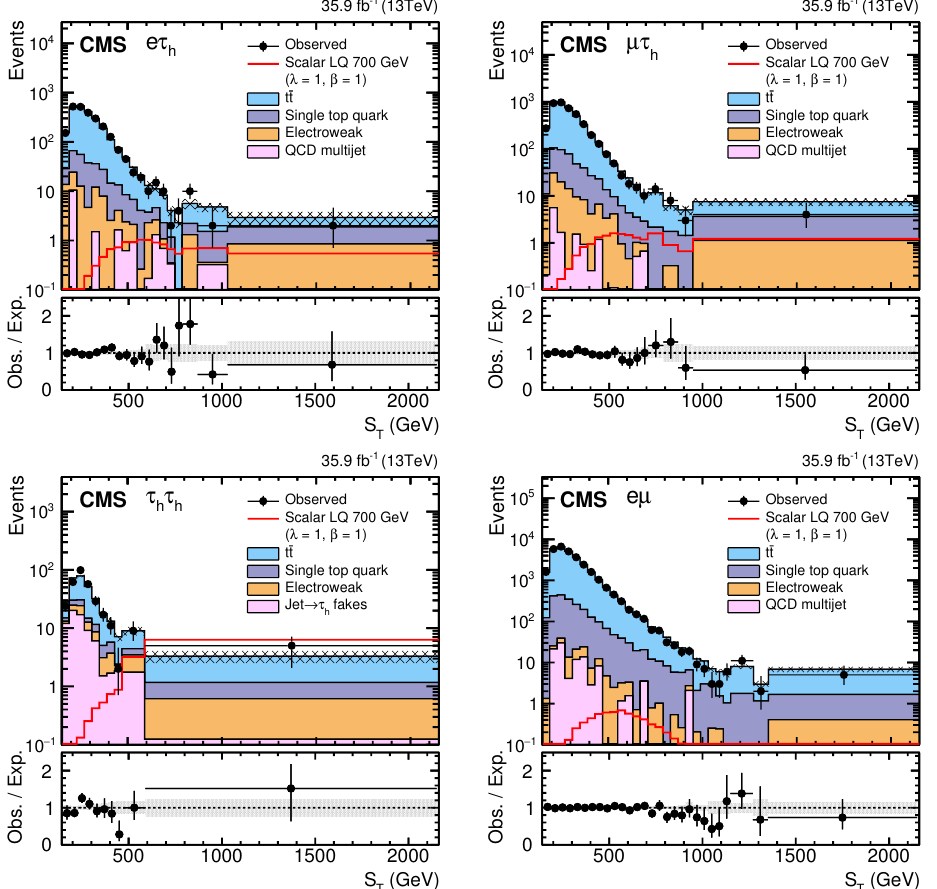
Figure 3 . Observed S T distribution in the e (cid:28) h (upper left), (cid:22)(cid:28) h (upper right), and (cid:28) h (cid:28) h (lower left) signal regions, as well as in the e (cid:22) (lower right) control region, compared to the expected SM background contributions. The distribution labeled \electroweak" contains the contributions from W+jets, Z+jets, and diboson processes. The signal distributions for single-LQ production with mass 700 GeV are overlaid to illustrate the sensitivity. For the signal normalization, (cid:21) = 1 and (cid:12) = 1 are assumed. The background uncertainty bands represent the sum in quadrature of statistical and systematic uncertainties obtained from the (cid:12)t. The lower panels show the ratio between the observed and expected events in each bin. In all plots, the horizontal and vertical error bars on the data points represent the bin widths and the Poisson uncertainties,